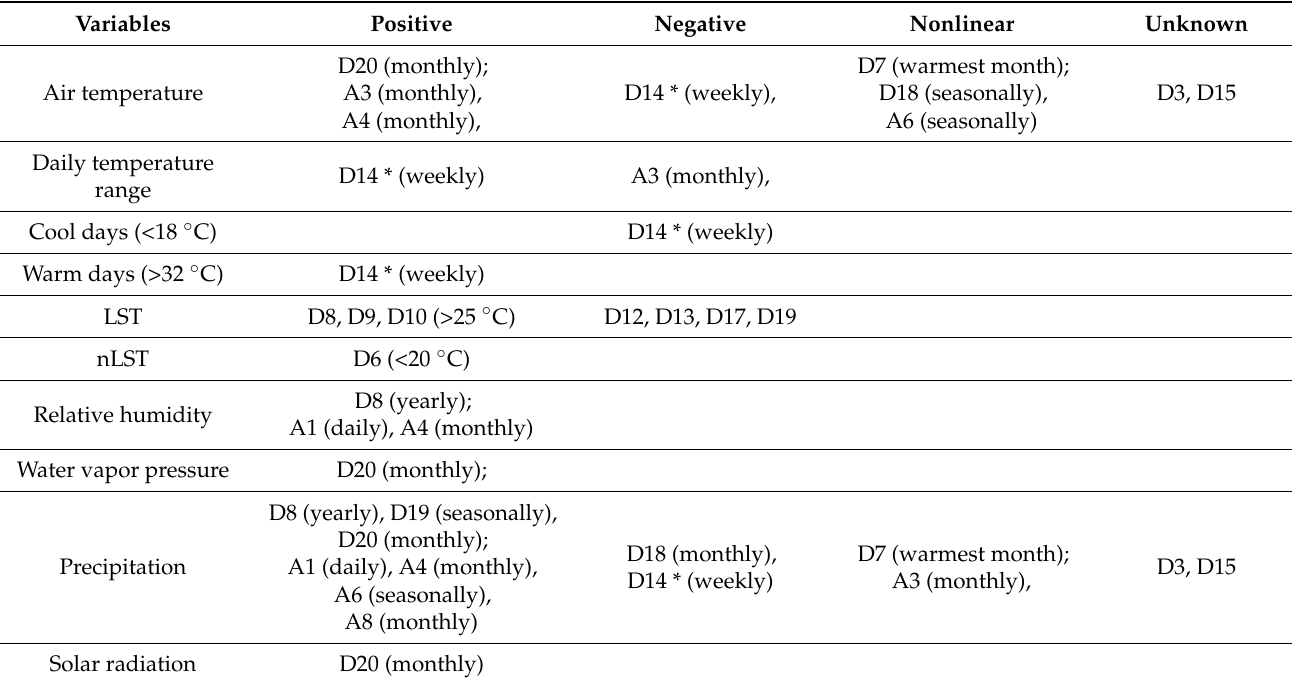
Table 3. Effect of climatic variables on dengue-related